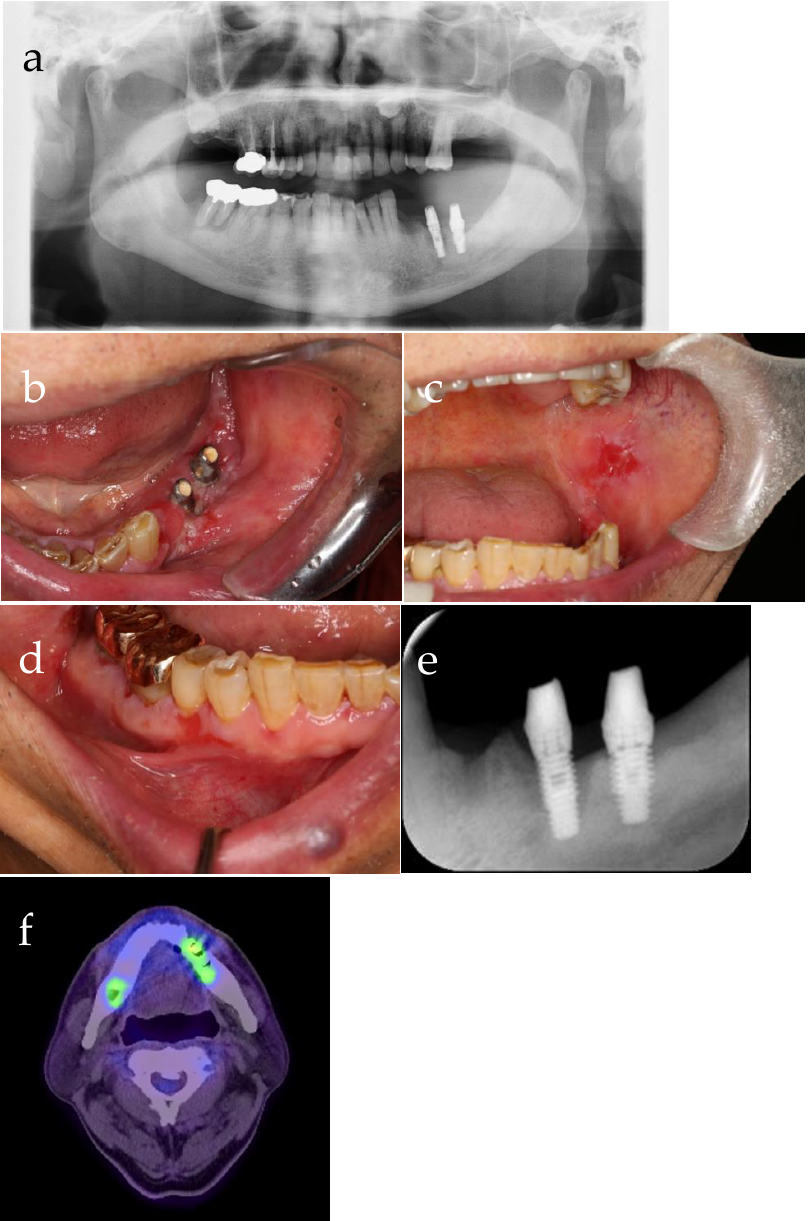
Figure 1. Intraoral photograph from the first visit: ( a ) Peri-implant ulcer, ( b ) oral lichenoid lesions of the bilateral buccal mucosa, ( c ) Nikolsky’s phenomenon of the gingiva, ( d ) panorama X-ray photograph (X-P), ( e ) dental X-P, and ( f ) 18 F-fluorodeoxyglucose positron emission